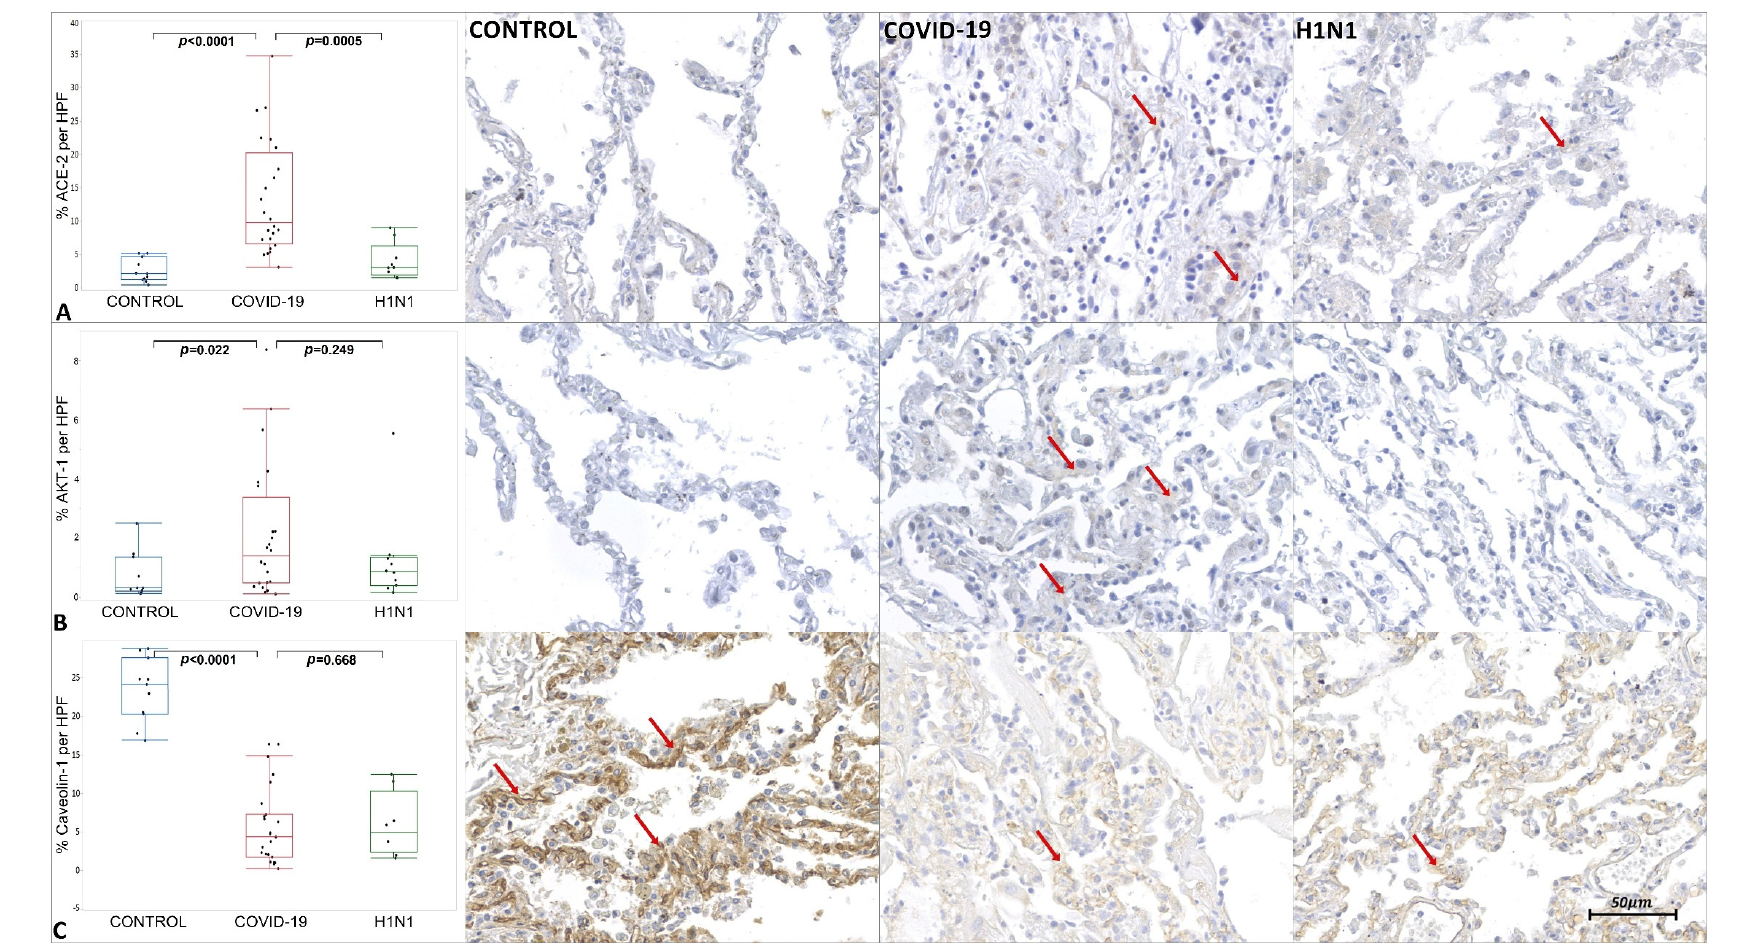
Figure 1. Graphics show tissue immunoexpression of ACE-2, AKT-1 and Caveolin-1 (percentage per HPF). ( A ) Comparative graphs between the CONTROL, COVID-19 and H1N1 groups and photomicrographs of tissue immunoexpression of ACE-2 in type II pneumocytes represented by the red arrow, of the respective groups. ( B ) Comparative graphs between the CONTROL, COVID-19 and H1N1 groups and photomicrographs of tissue immunoexpression of AKT-1 in the alveolar epithelium, represented by the red arrow, of the respective groups. ( C ) Comparative graphs between the CONTROL, COVID-19 and H1N1 groups and photomicrographs of tissue immunoexpression of Caveolin-1 in the alveolar epithelium, represented by the red arrow, of the respective groups.